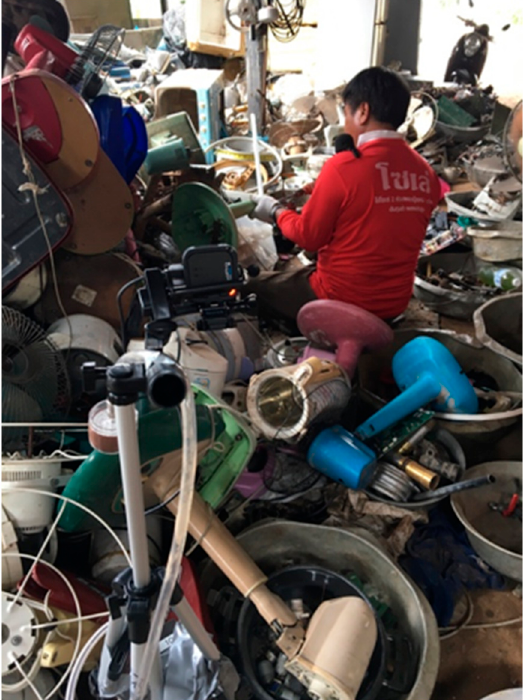
Figure 1. Video snapshot from a GoPro camera of an electronic waste (e-waste) worker dismantling e-waste during a work shift.